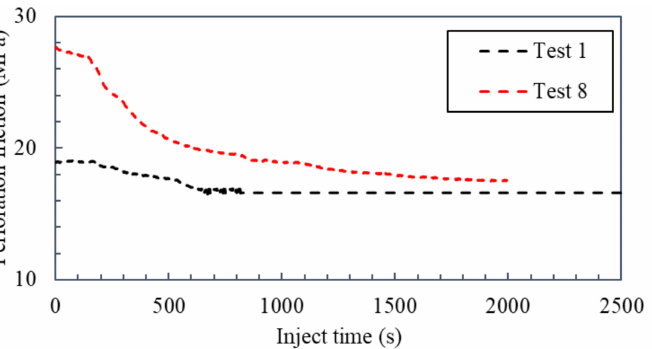
Figure 7. Perforation friction vs injection time at different injection flowrates (1 m 3 40/70 mesh quartz sand).